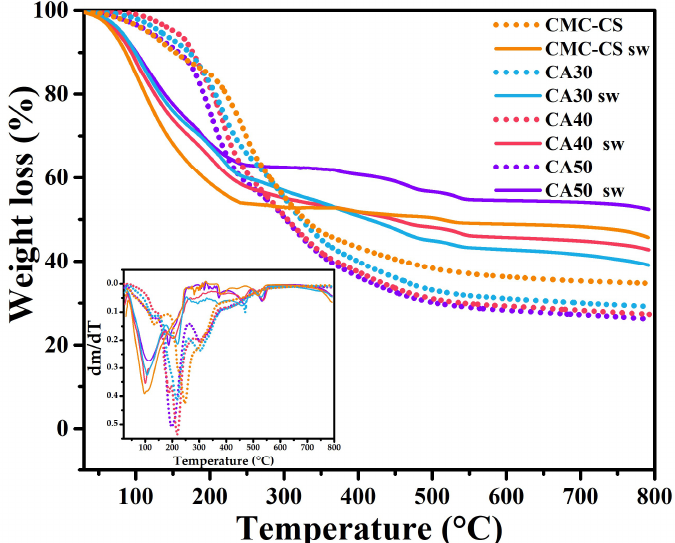
Figure 6. TGA curves of the CMC-CS and CMC-CS sw hydrogels at different CA proportions. Inset: DTGA curves of the electrolytes.